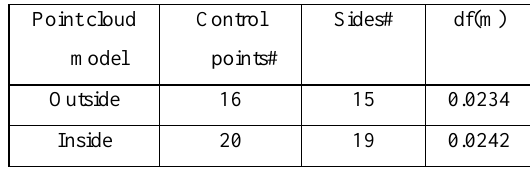
Table 2. The accuracy evaluation results for the outside and inside 3D point cloud model.